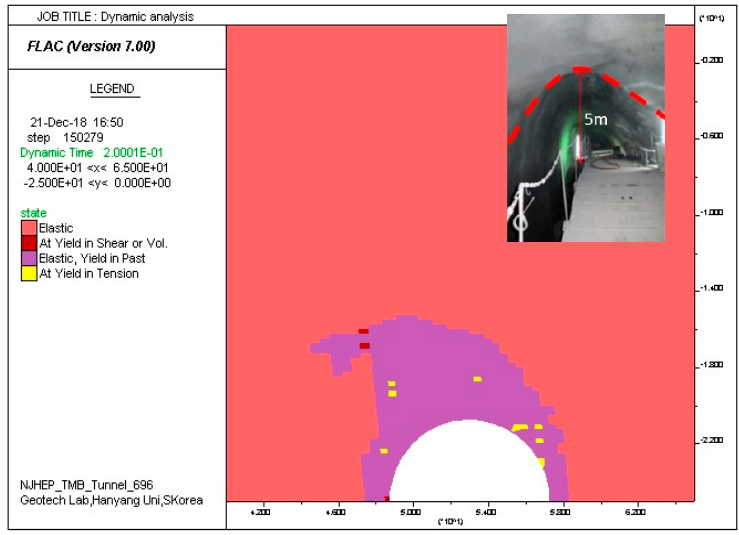
Figure 7. Failure zone around Tunnel 696.